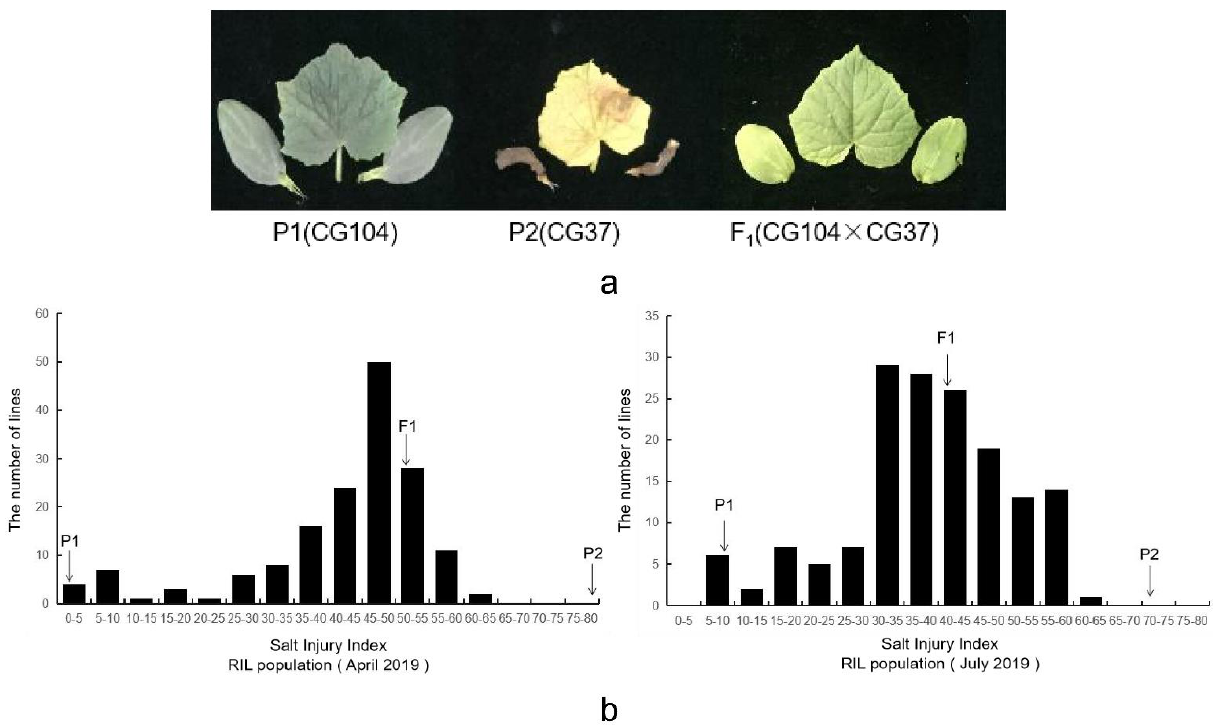
Figure 2. Frequency distribution of salt injury index among the recombinant inbred line (RIL) population. ( a ) Performance of the resistant parental line ‘CG104’, the sensitive line ‘CG37’ and their F 1 hybrid progeny at 7 d after 200 mmol·L −1 NaCl treatment; ( b ) Frequency distribution of the salt injury index among the ‘CG104’ × ‘CG37’ RIL population in two treatments. The abscissa indicates the salt injury index of the RIL population, the ordinate indicates the number of lines. The frequency distributions in April 2019 and July 2019 each presented a continuous distribution from resistant to sensitive phenotypes.